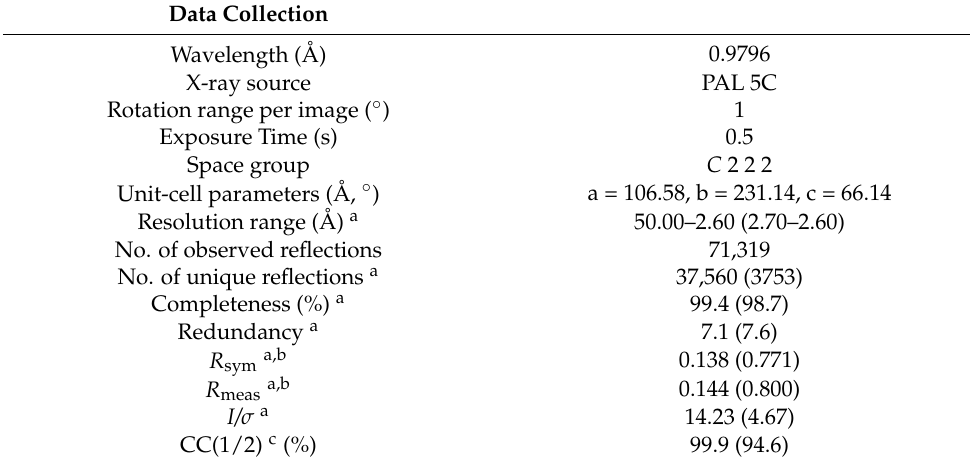
Table 1. Initial X-ray diffraction